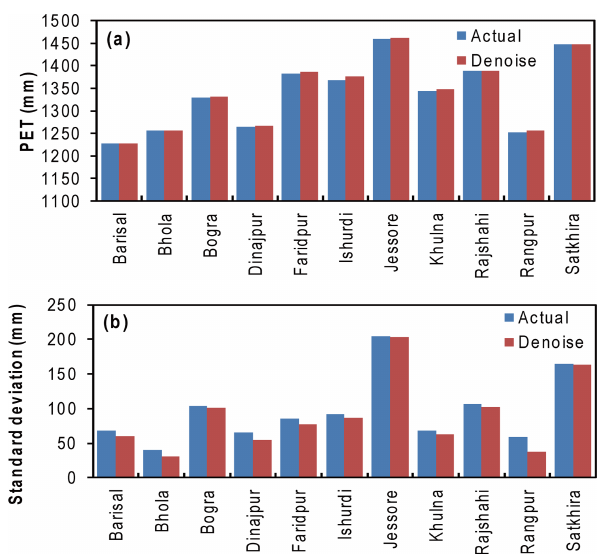
Figure 5. Comparison between actual and wavelet denoise P ET time series (a) mean and (b) standard